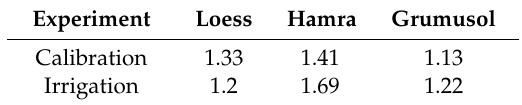
Table 1. Soil bulk density (kg/m 3 ) measured in laboratory experiments for all soils.